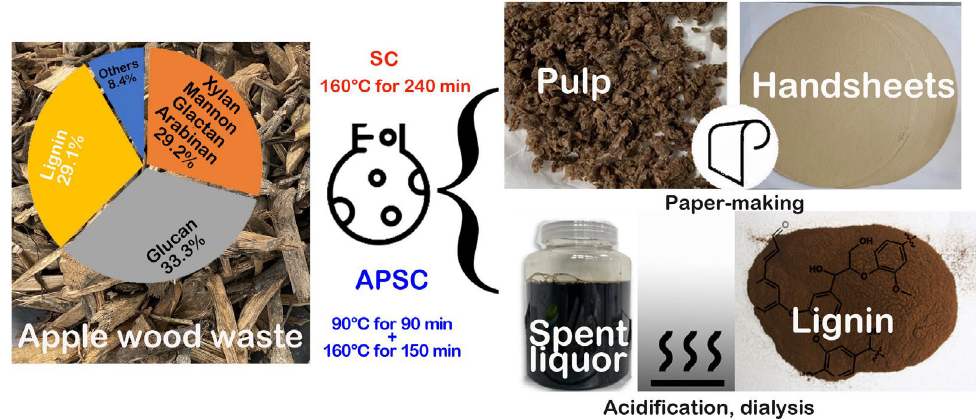
Figure 1. Flow diagram of the isolation of cellulose pulp and lignin form AWW by SC and APSC.